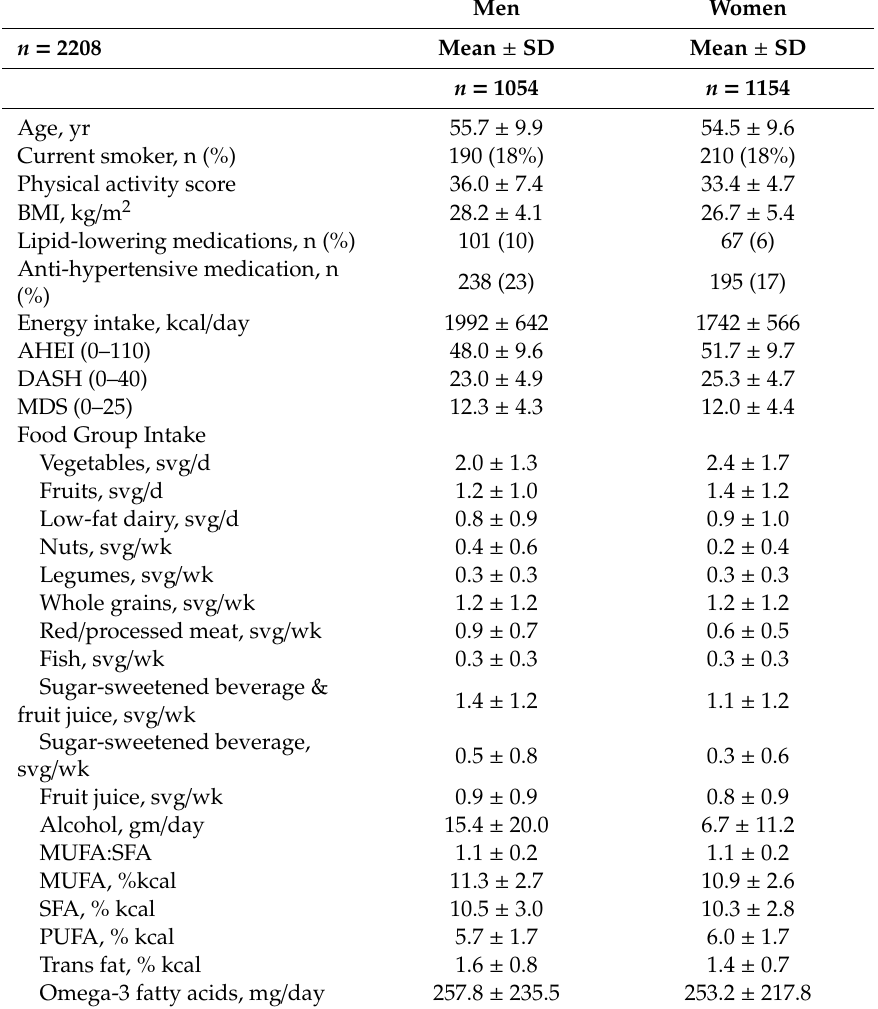
Table 1. Sample characteristics at examination five of the Framingham O ff spring Study.